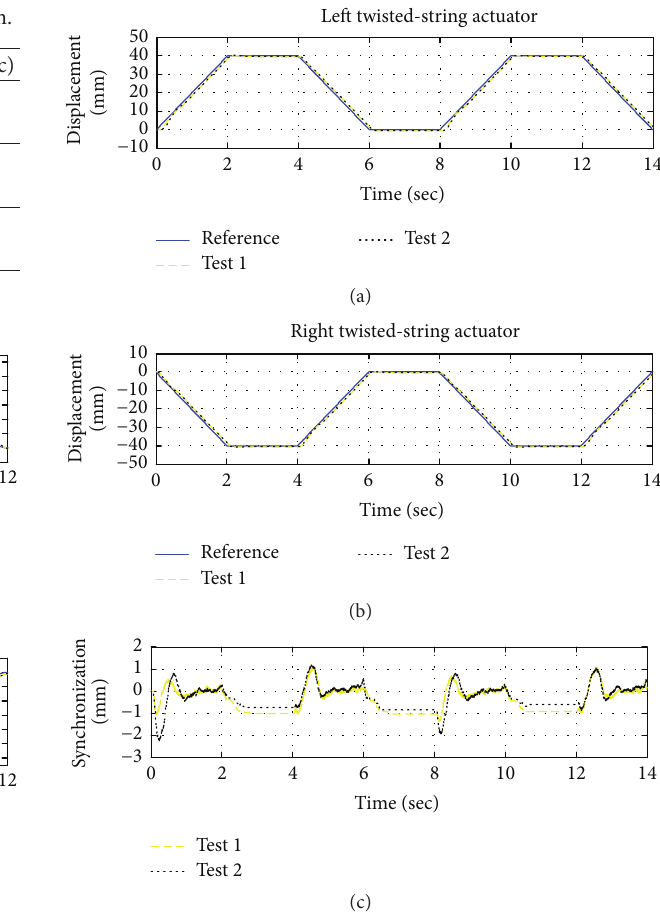
Figure 14: Experimental outcome of LQR-FC controller (trape- zoidal motion): (a) comparison between reference trajectory and actual trajectories of left actuator; (b) comparison between reference trajectory and actual trajectories of right actuator; (c) synchroniza- tion errors between left and right